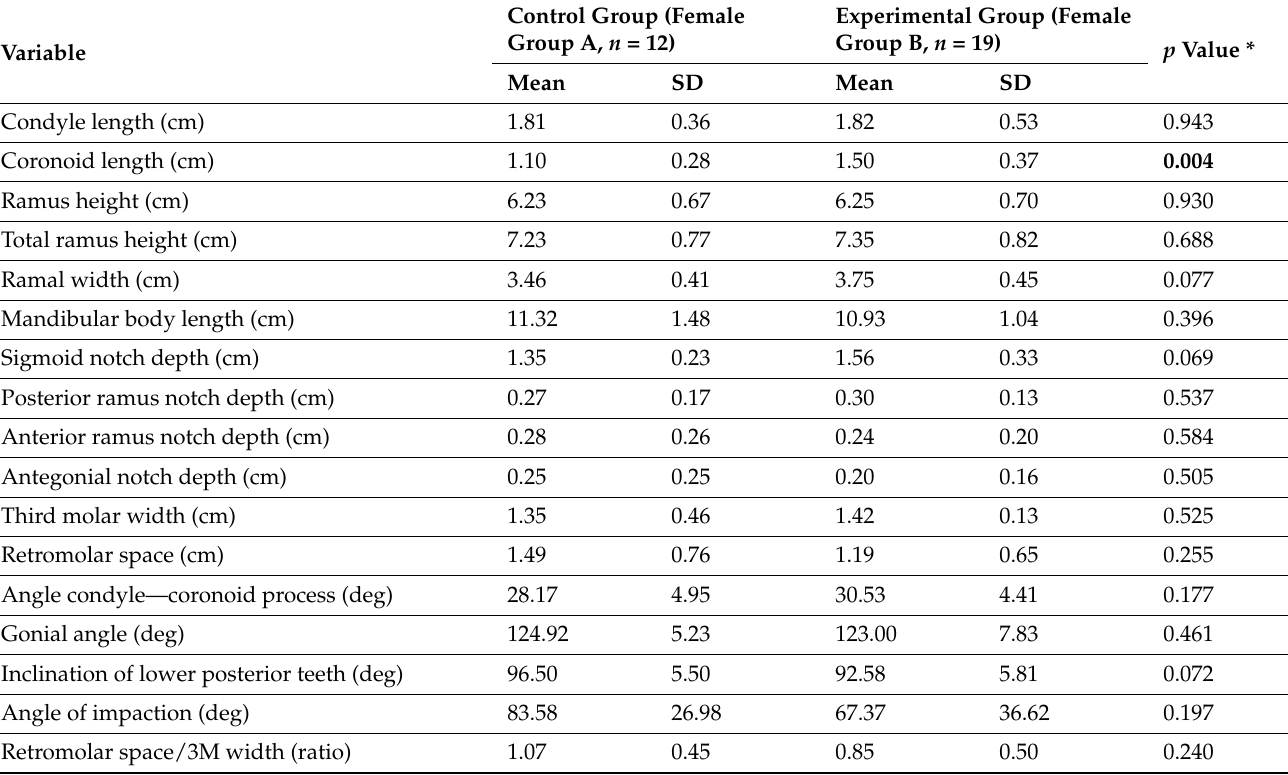
Table 4. Comparison between female group A (FA) and group B